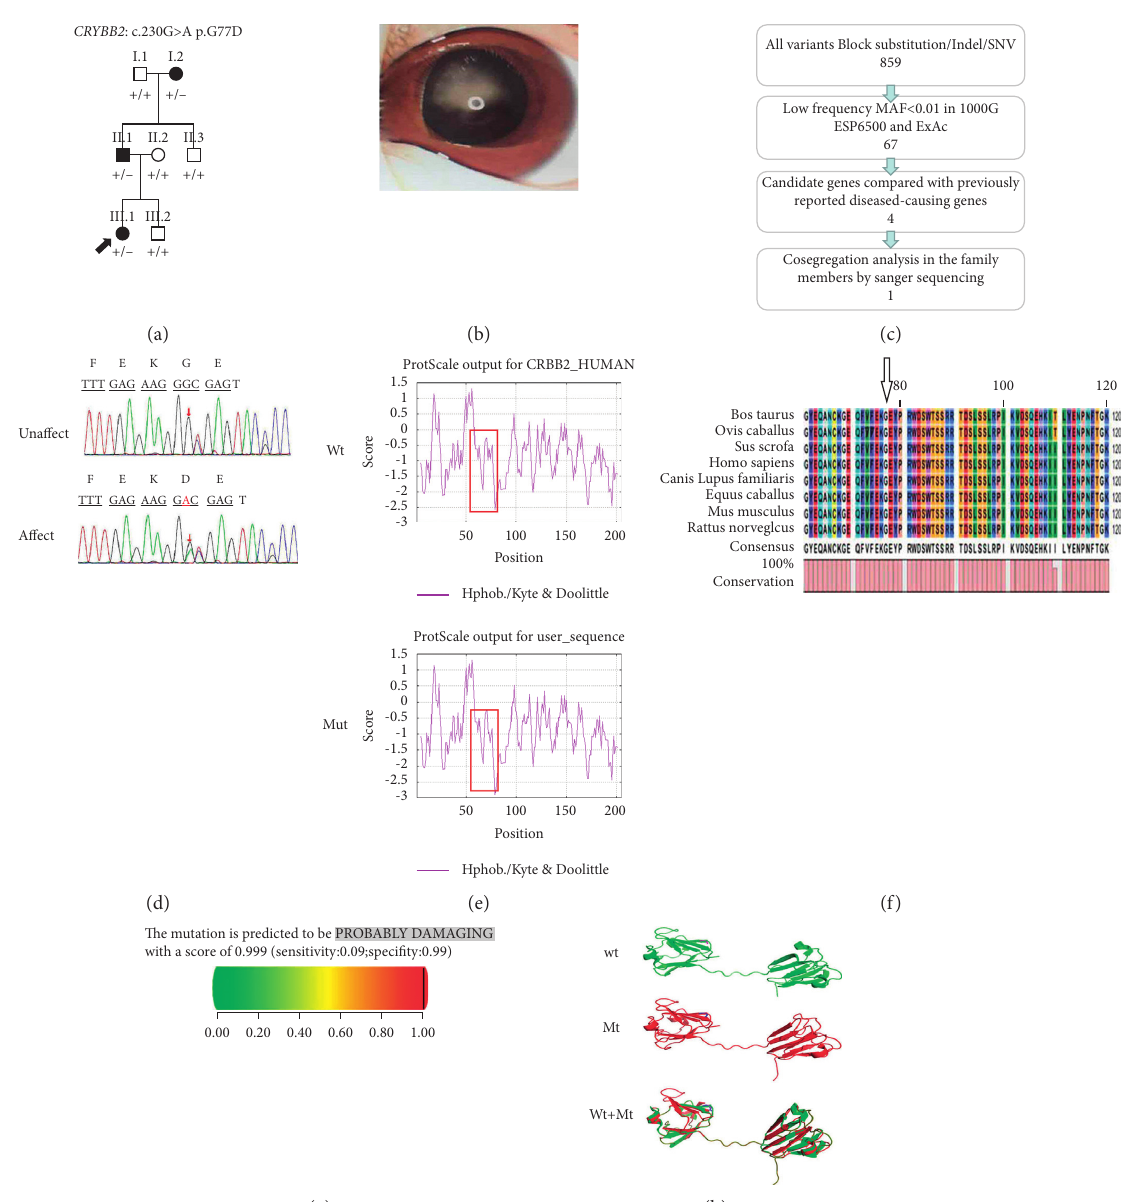
the right eye and 1.0 logMAR (Snellen equivalent 20/200) in the left eye as measured with ETDRS picture symbols. His anterior segment had no abnormalities except for cataracts.